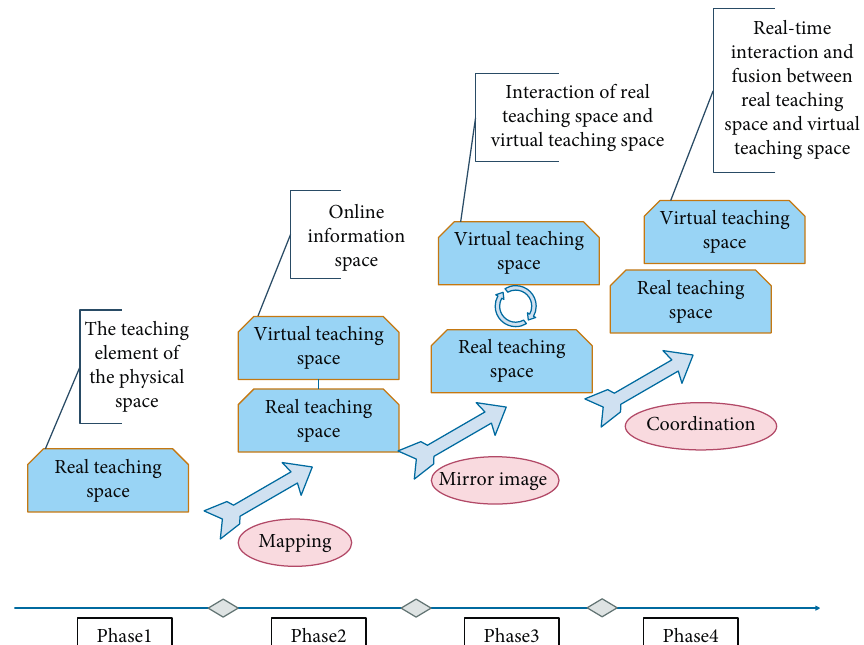
Figure 11: Framework of mapping, mirroring, and collaborative operation between physical reality teaching space and virtual teaching